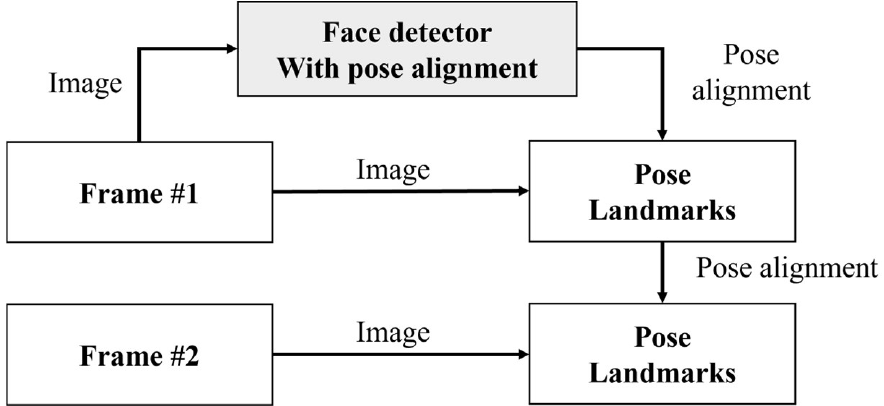
Figure 5. MediaPipe pipeline.